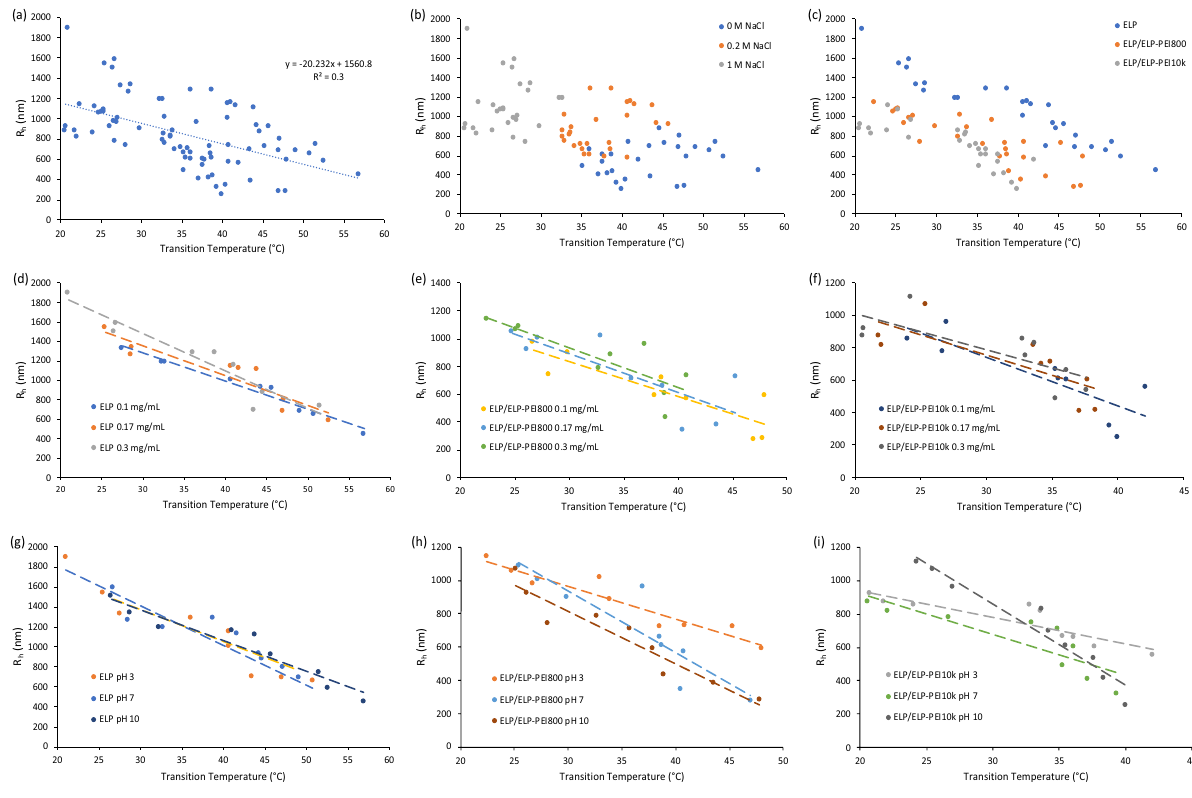
Figure 5. ( a ) A weak relationship was seen between R h and T t with an R 2 of 0.3. ( b ) K-means cluster analysis was used to elucidate the primary driver of the relationship between R h and T t . The three groups indicated by K-means cluster analysis to be important for determining R h versus T t are based on the concentration of salt. ( c ) Separating the R h versus T t graph by polymer type shows that increasing the molecular weight of PEI attached to ELP decreased the R h and T t simultaneously. Graphs for ( d ) ELP, ( e ) ELP/ELP-PEI800, and ( f ) ELP/ELP- PEI10K demonstrate that increasing polymer concentration decreases T t , but has a small influence on R h . ( g ) ELP exhibits minimal effects from a change in pH. Coupling ELP to PEI imposes a pH sensitivity that allows for a control over R h for ( h ) ELP/ELP-PEI800 and ( i )